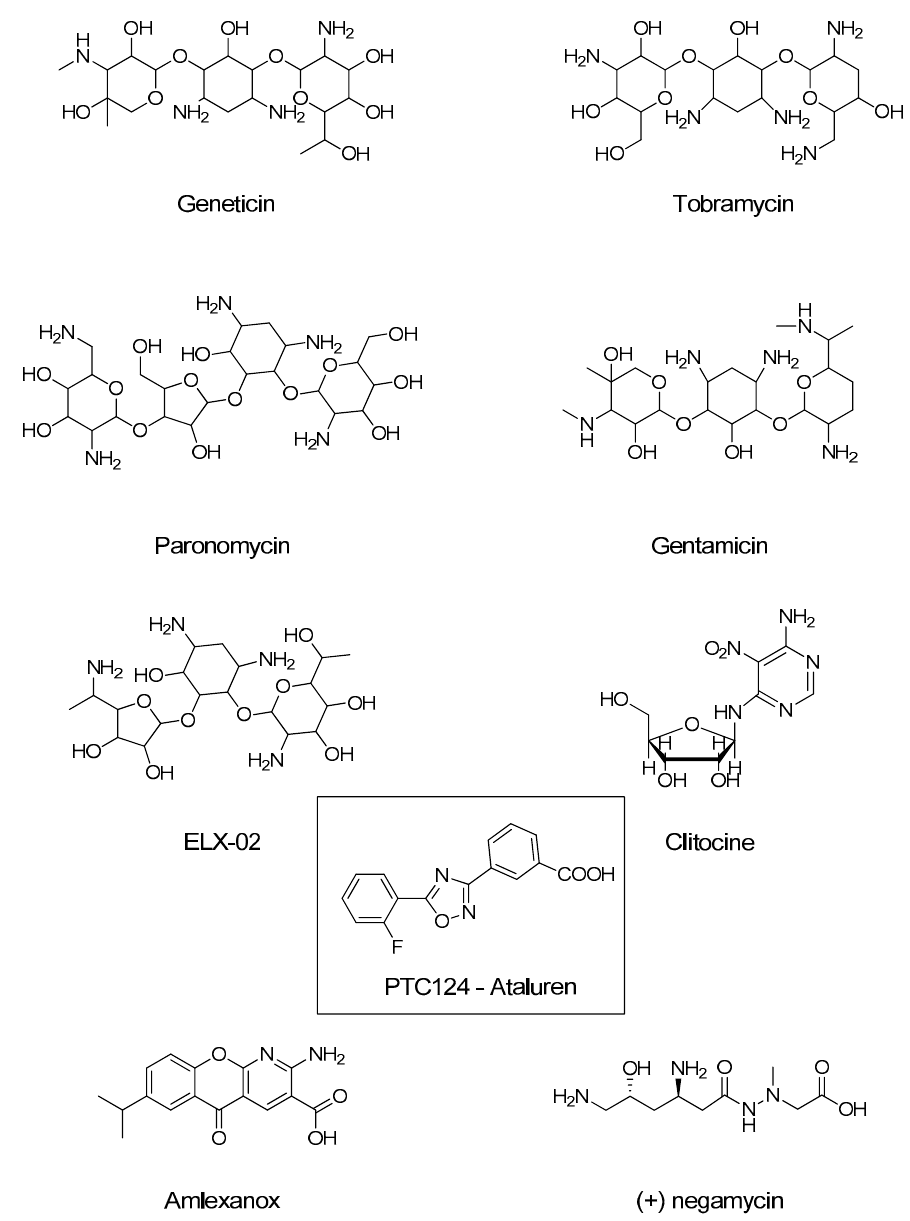
Figure 3. Different structures of proposed translational readthrough-inducing drugs (TRIDs). Figure 3. Di ff erent structures of proposed translational readthrough-inducing drugs Phase I and II clinical trials, including healthy subjects and CF and Duchenne muscular dystrophy (DMD) patients, have evaluated the long-term safety of ataluren.